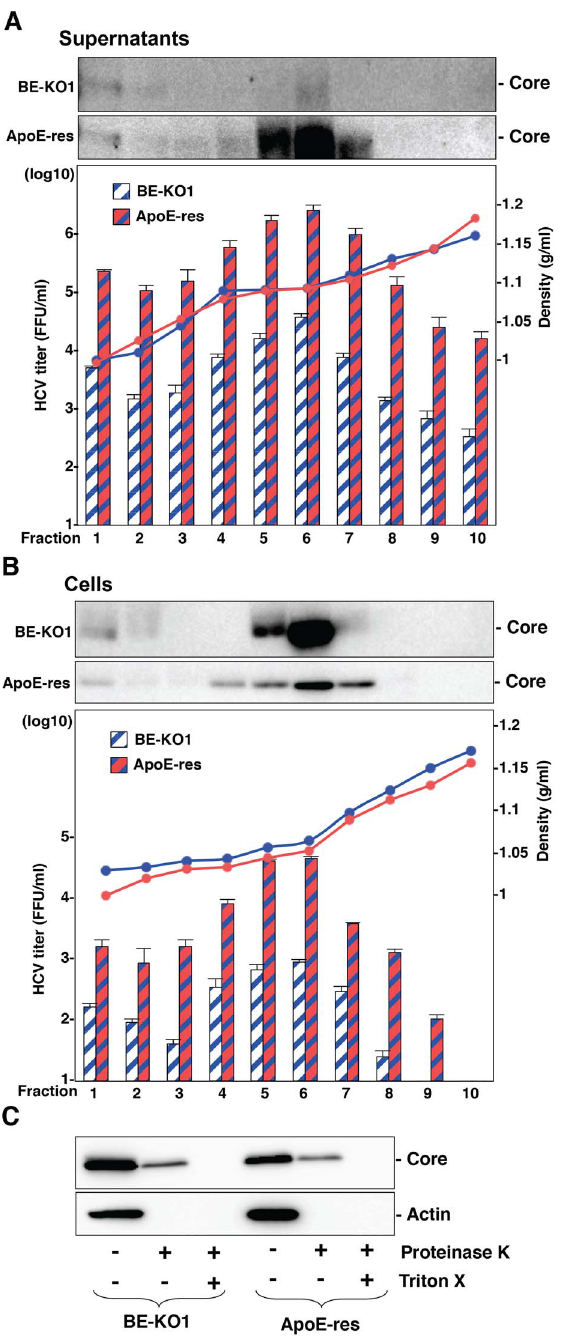
Figure 7. Apolipoproteins participate in the post-envelopment step of the HCV life cycle. The supernatants (A) and lysates (B) of BE- KO1 and ApoE-restored (ApoE-res) cells infected with HCVcc at an MOI of 1 were subjected to density gradient fractionation. Each fraction was subjected to immunoblotting using anti-Core antibody (upper). The infectious titers and densities of each fraction were determined (lower). (C) The lysates of BE-KO1 and ApoE-res cells infected with HCVcc at an MOI of 1 were subjected to proteinase K digestion protection assay. Lysates were separated into 3 parts and incubated for 1 h on ice in the presence or absence of 50 m g/ml proteinase K with/without pretreat- ment with 5% Triton-X and then subjected to immunoblotting.